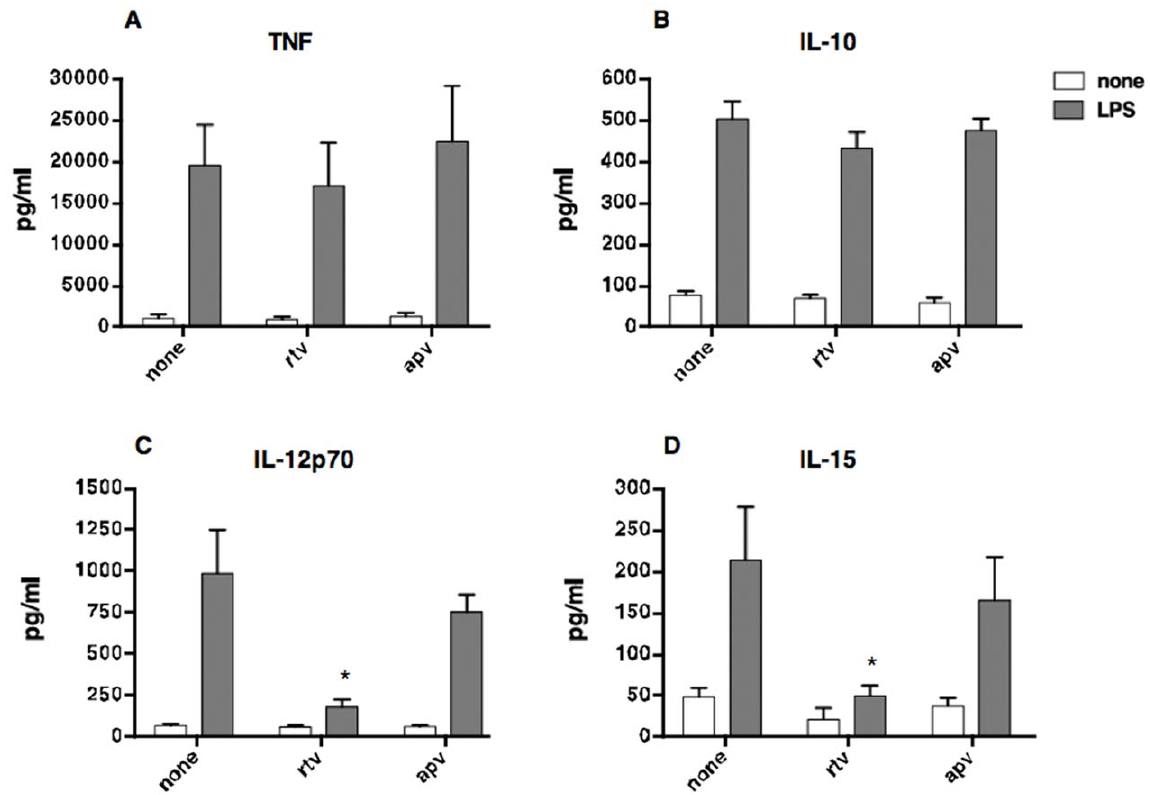
Figure 3. Responsiveness to LPS of immature DCs generated in the presence of HIV-1 protease inhibitors: cytokines release. iDCs generated in the absence (none) or presence of ritonavir (rtv) or amprenavir (apv) were collected, washed and exposed to LPS (100 ng/ml). After 24 hours, cytokines were measured in supernatants by ELISA (A–D). Bars graph reports mean and standard deviation calculate on ten independent experiments. (* p , 0.005).